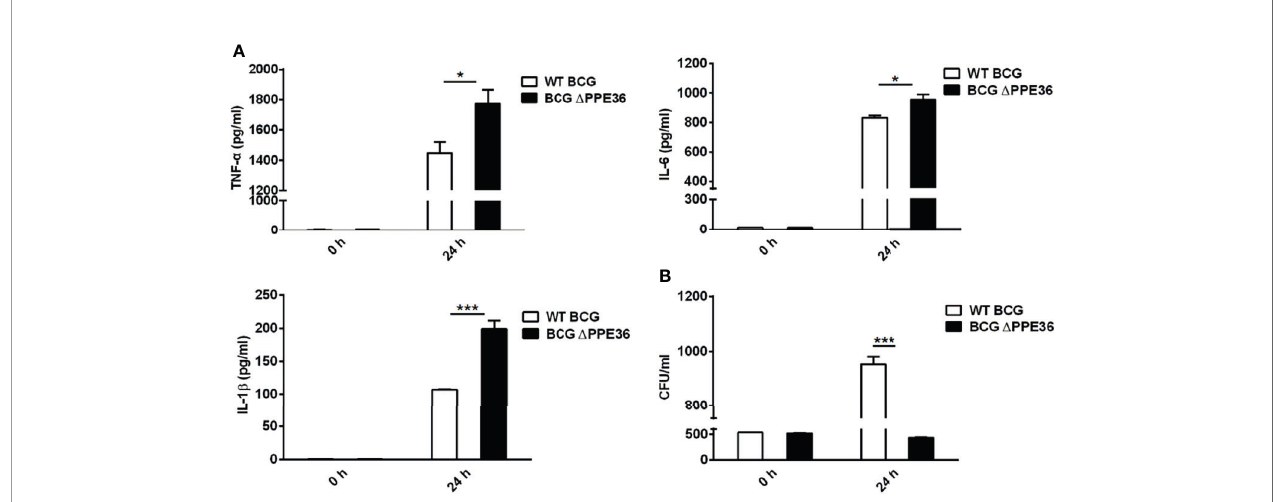
FIGURE 2 | PPE36 suppressed macrophage in fl ammatory cytokine production. (A) Levels of TNF- a , IL-6, and IL-1 b in the WT BCG- or BCG △ PPE36-infected BMDMs. (B) Bacterial loads in the WT BCG- or BCG D PPE36-infected BMDMs. *p < 0.05, ***p